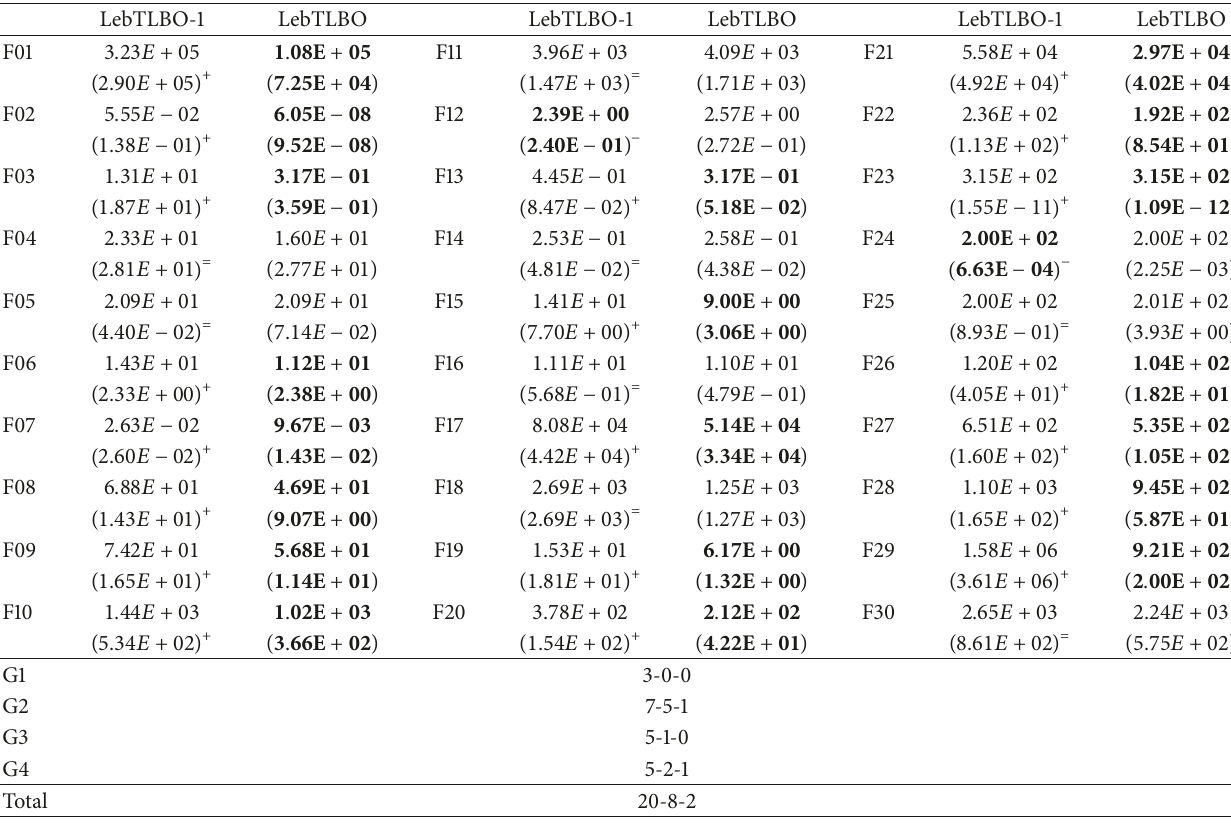
Table 7: Comparison between LebTLBO and LebTLBO-1.